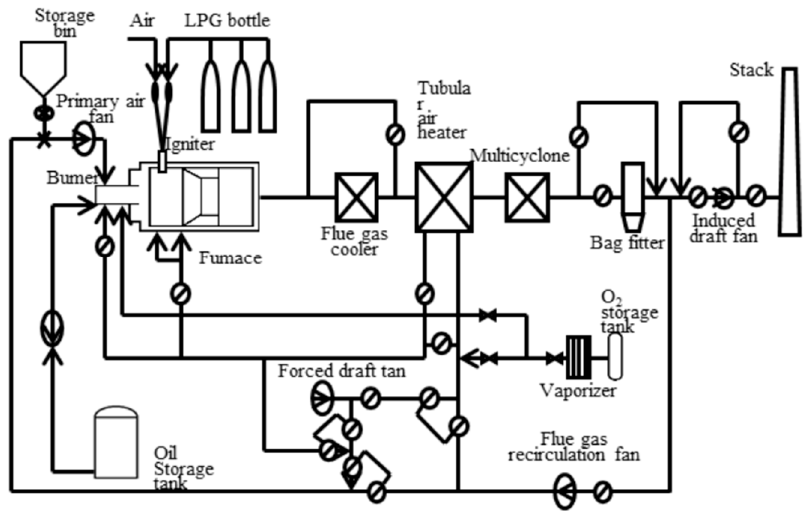
Figure 3. The process of flue gas recycling [13].